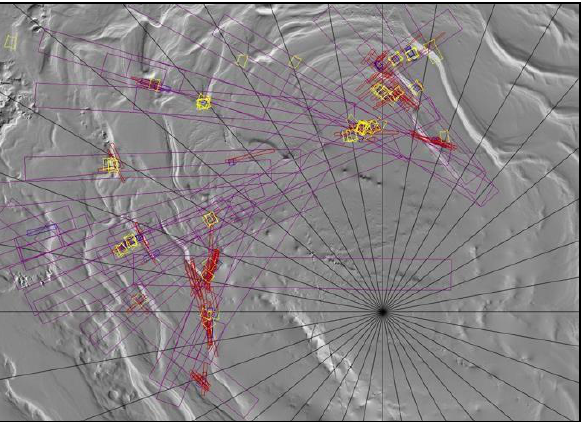
Figure 3: Distribution of SCT footprints from HiRISE,